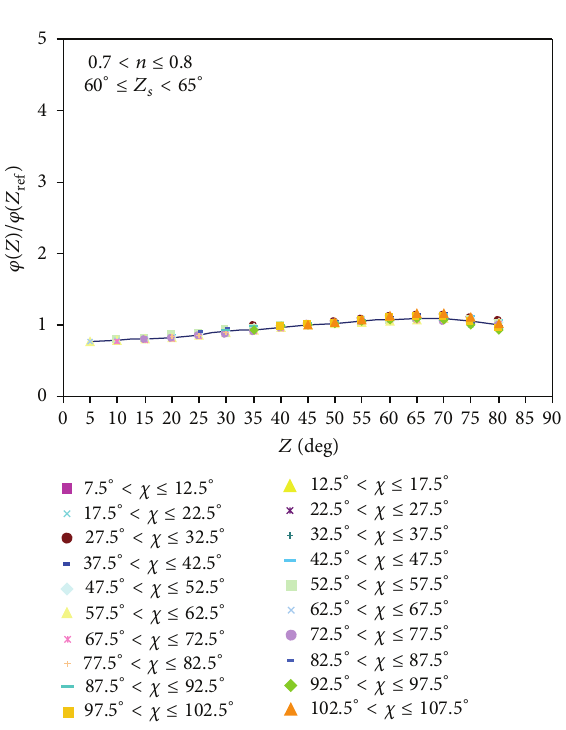
Figure 5: Example of the plots of 𝜑(𝑍)/𝜑(𝑍 subzone zenith angle 𝑍 from different concentric zones of 𝜒 for solar zenith angle 60 ∘ ≤ 𝑍 𝑠 < 65 ∘ and cloud index 0.7 < 𝑛 ≤ 0.8 .